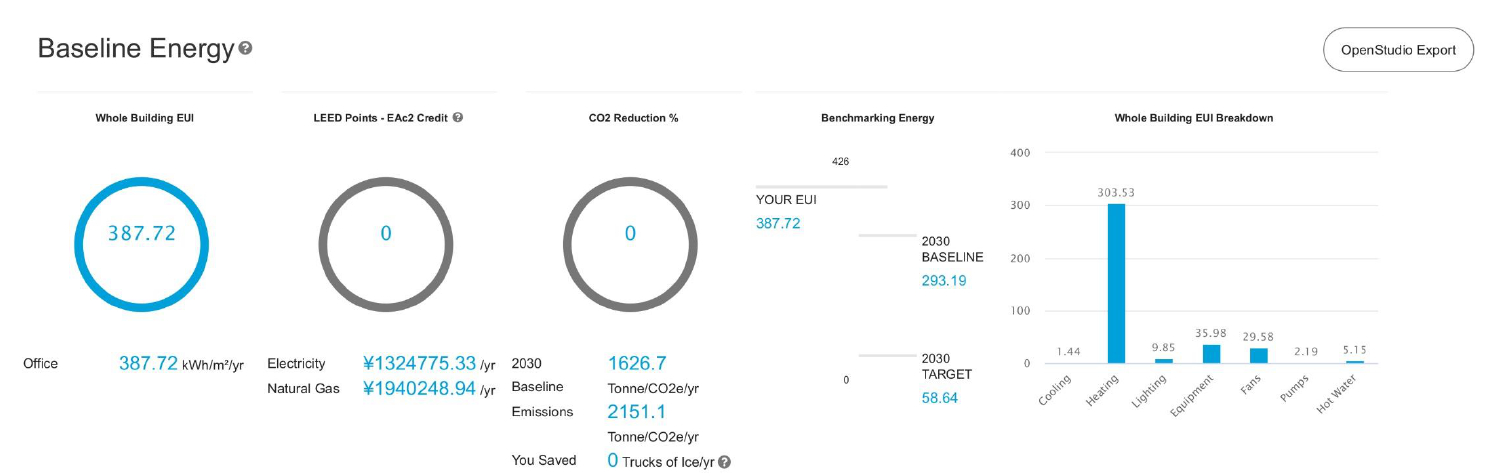
Figure A25. Zone 5-B Lanzhou, Gansu (pre-COVID-19 scenario).